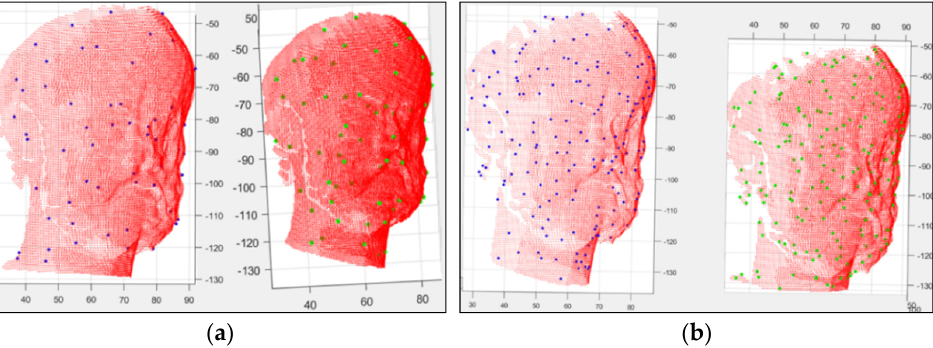
Figure 13. Distribution of detected keypoints for the point clouds data of Aristotle sculpture using: ( a ) intrinsic shape signatures (ISS) algorithm; ( b ) local surface patch (LSP) algorithm.